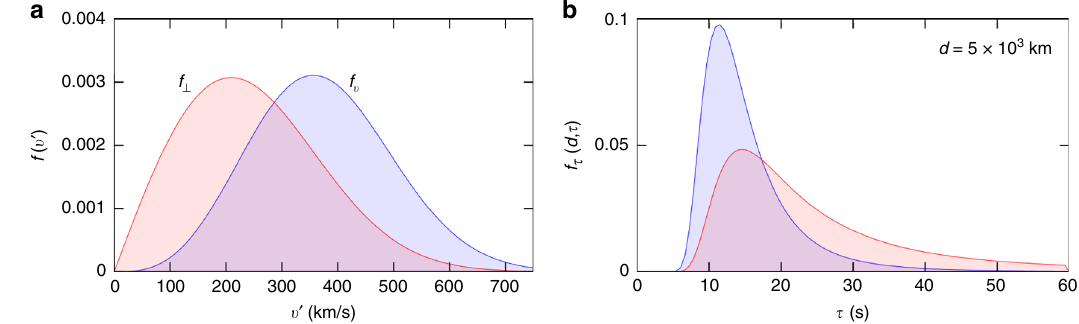
Fig. 7 Velocity and crossing time distributions. a The blue curve shows the velocity distribution for dark matter objects that cross the Global Positioning System constellation Eq. (16) while the red curve shows the corresponding distribution for the velocity component normal to the domain wall Eq. (17). b The resultant single-clock crossing-time, τ = d / v ′ , distribution for walls of width d = 5 × 10 3 km